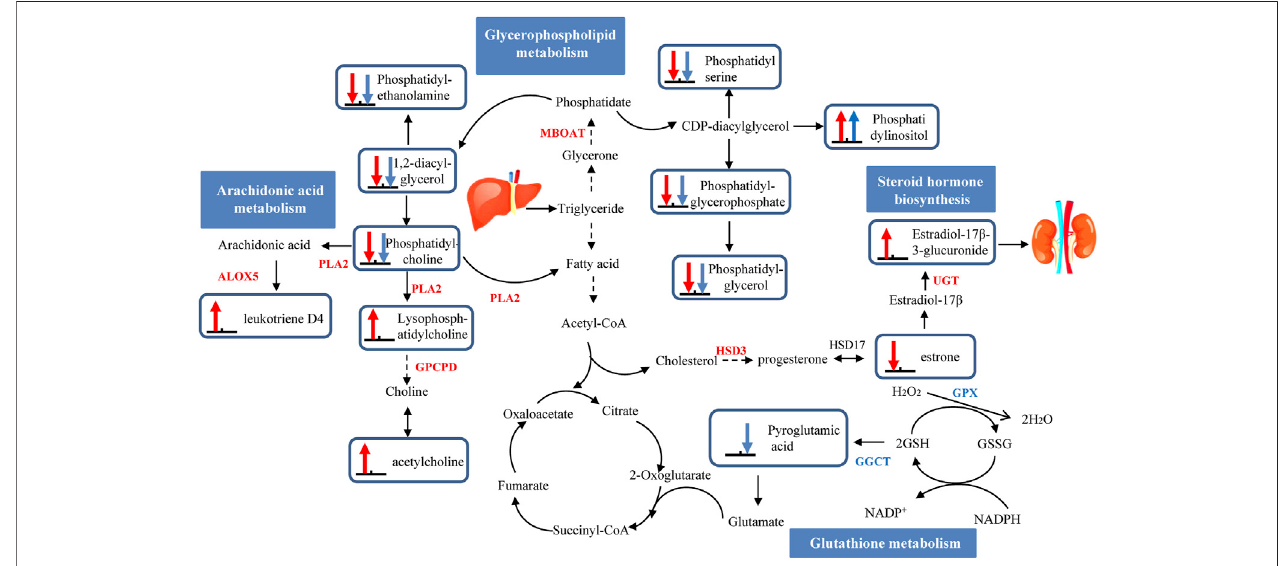
FIGURE6| Aschematicpresentationofhepatotoxicitypathwaysidenti fi edbymultiomicsinducedbyAAIinneonatalandadultmice.Theidenti fi edmetabolitesand genes involved in neonatal mice pathways are marked in red, and adult mice are marked in blue. Up arrows indicate upregulation, and down arrows indicate downregulation. Abbreviations: ALOX5: arachidonate 5-lipoxygenase; CEL: bile salt-stimulated lipase; GSH: reduced glutathione; GSSG: oxidized glutathione; GGCT: gammaglutamylcyclotransferase; GPX: glutathione peroxidase; LIPC: phosphatidate phosphatase; MBOAT: lysophospholipid acyltransferase; PLA2: phospholipase A2; PNLIP: pancreatic triacylglycerol lipase; PNPLA: patatin-like phospholipase domain-containing